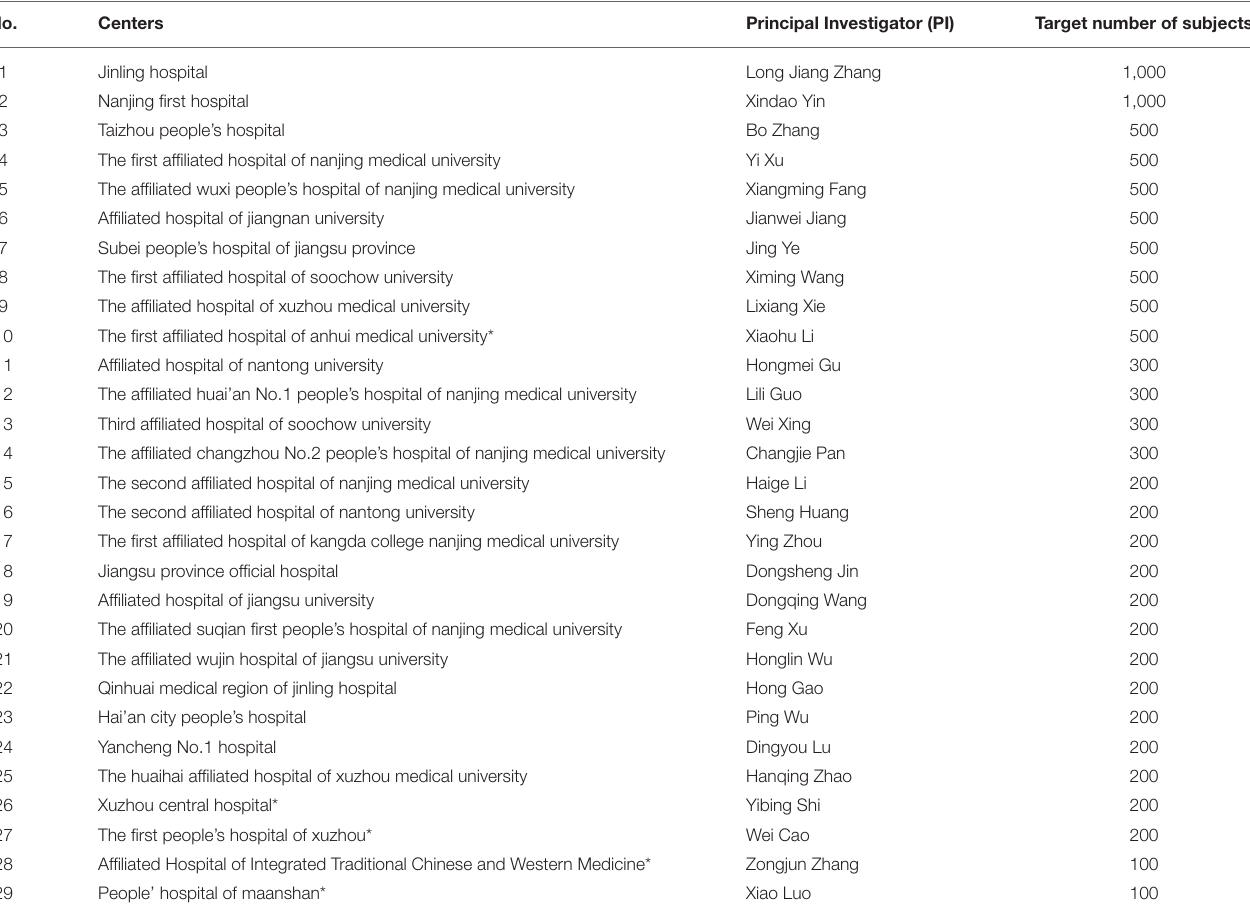
TABLE 6 | Detail information of the medical